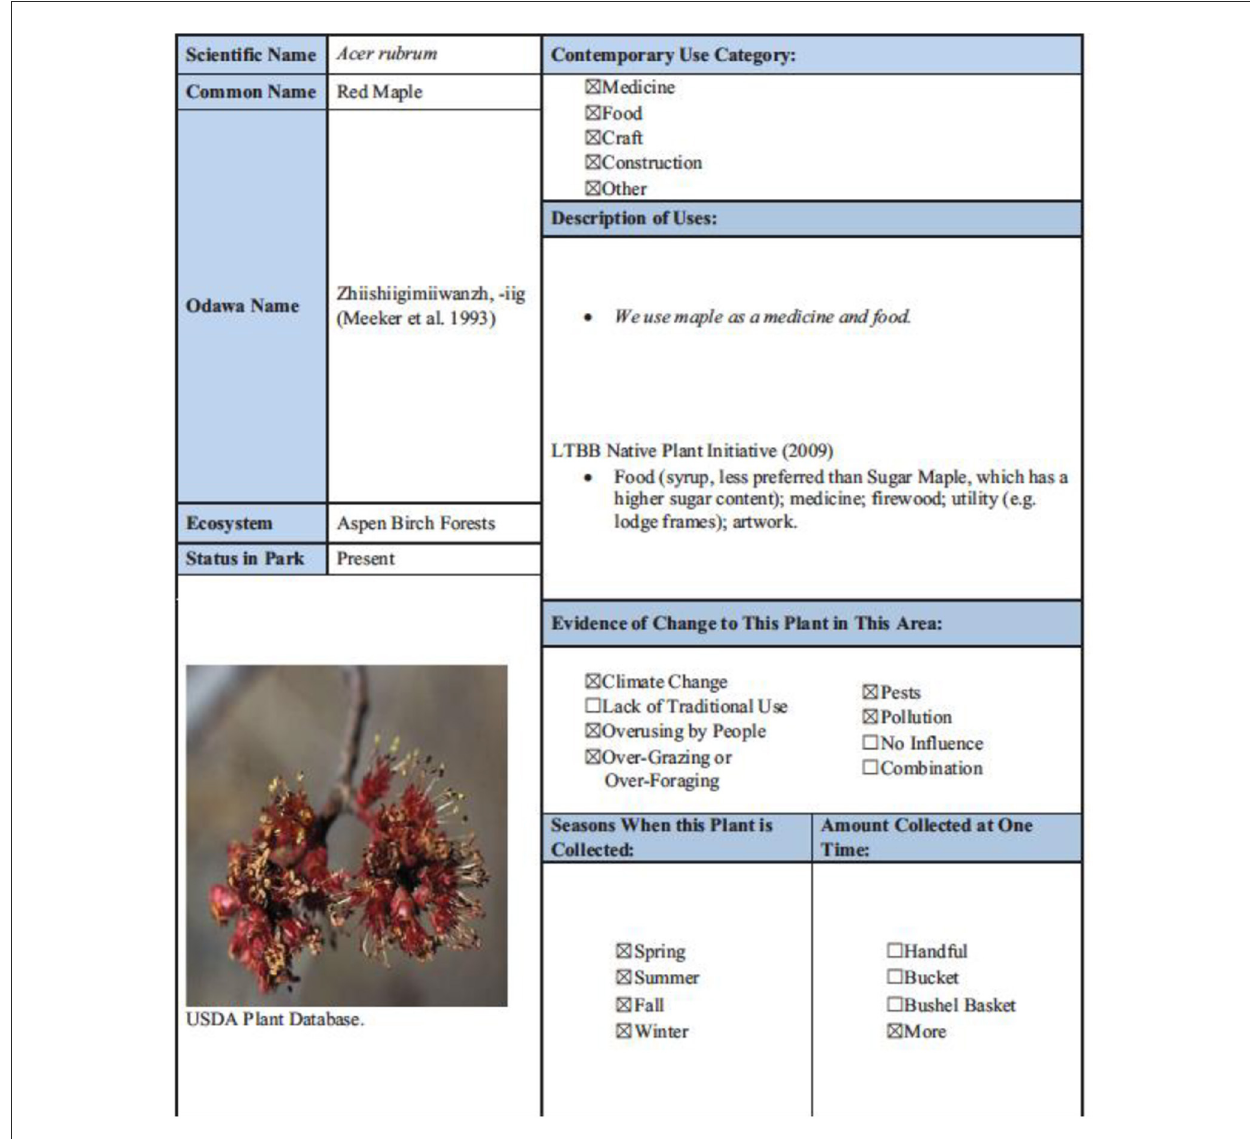
FIGURE3B Red maple entry from plant